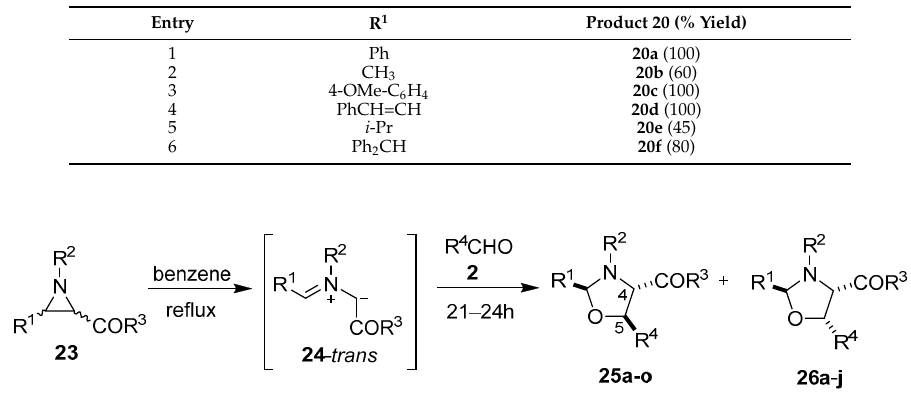
Table 2. Cycloaddition of trans -azomethine ylide 24 to aldehydes 2 (Scheme 4). Table 1. Cycloaddition of azomethine ylide 19 to aldehydes 2a – f (Scheme 3).